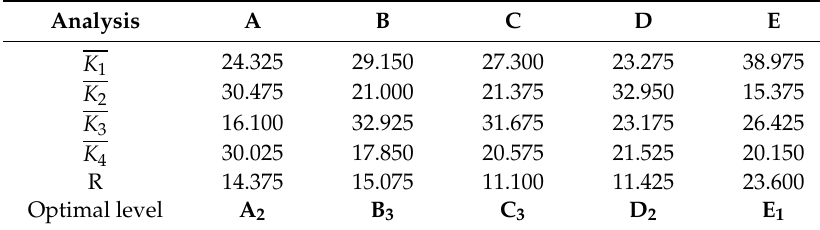
Table 5. Range analysis of the L16 (4 5 ) experimental